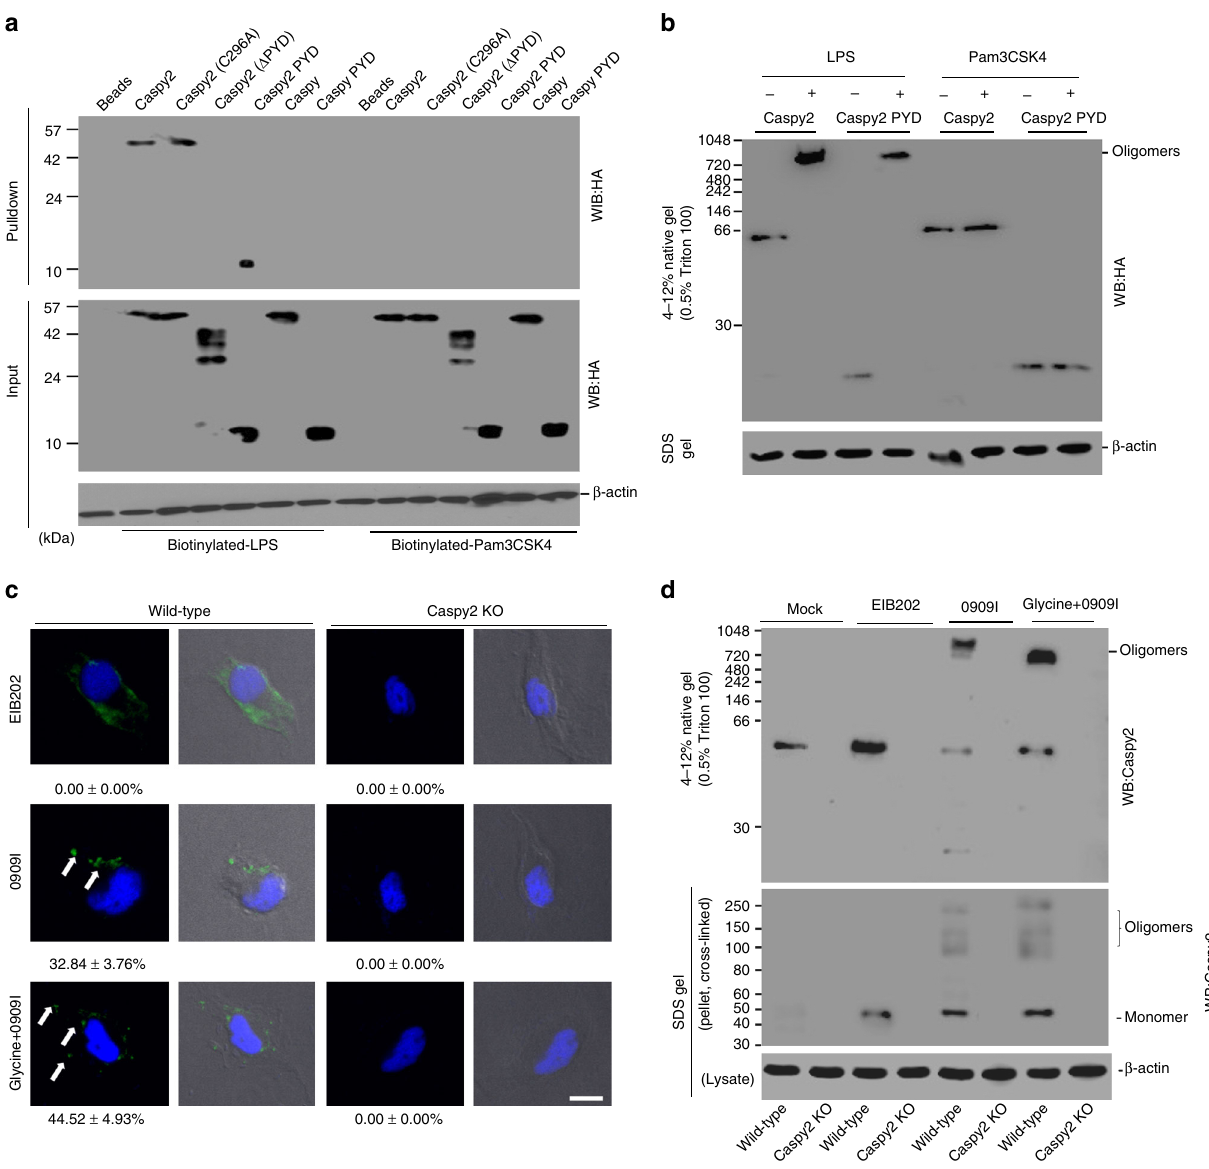
Fig. 3 Caspy2 directly binds to LPS to induce its oligomerization. a Streptavidin pulldown assays of the binding of biotin-conjugated LPS and Pam3CSK4 to puri fi ed HA-tagged caspy2, caspy2 (C296A), caspy2 ( Δ PYD), caspy2 PYD, caspy and caspy PYD in transfected HEK293T cells. Shown are anti-HA immunoblots of pulled down proteins and total lysates (input). b Puri fi ed HA-tagged caspy2 and caspy2 PYD in transfected HEK293T cells were incubated with LPS or Pam3CSK4. The samples were analyzed by the pore-limited native gel electrophoresis. c Wild-type and caspy2 -KO ZF4 cells were infected with wild-type (EIB202) or 0909I E. piscicida (with/without 10 mM glycine) for 2 h at a multiplicity of infection (MOI) of 50. Confocal laser scanning microscopic analysis of nuclei (2-(4-amidinophenyl)-1H-indole-6-carboxamidine (DAPI), blue) and caspy2 foci (green, white arrowheads). Direct interference contrast (DIC)/phase images are shown. Scale bar, 10 µ m. Statistics of the percentages of cells showing signals for caspy2 foci are listed below. (Approximately 200 cells were counted in each sample. Mean ± SD of triplicate samples.) d Wild-type and caspy2 -KO ZF4 cells were infected with wild-type (EIB202) or 0909I E. piscicida (with/without 10 mM glycine) for 2 h at an MOI of 50, or left untreated (Mock). The samples were analyzed by the pore-limited native gel electrophoresis and immunoblotting (upper panel). Cell lysates and DSS cross-linked pellets from wild-type and caspy2 -KO ZF4 cells treated as indicated were analyzed by immunoblotting for caspy2 oligomerization (lower panel). WB western blot. Results are representative of